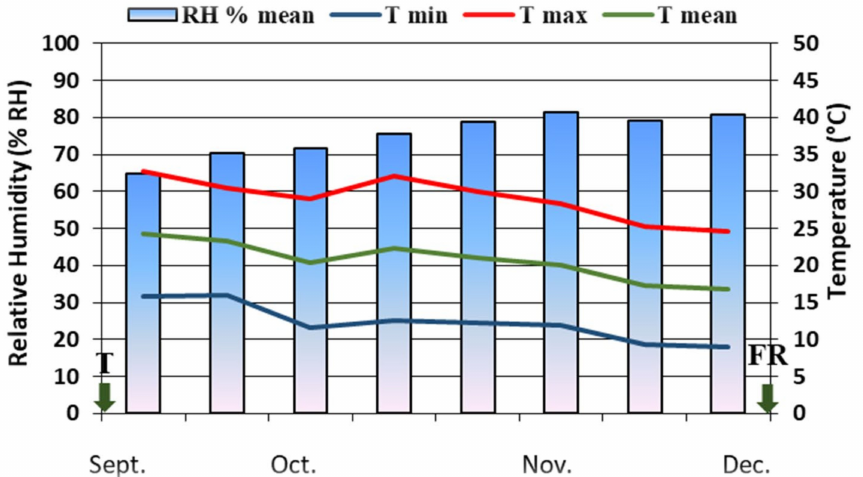
Figure 1. Temperature and relative humidity in the greenhouse during the crop